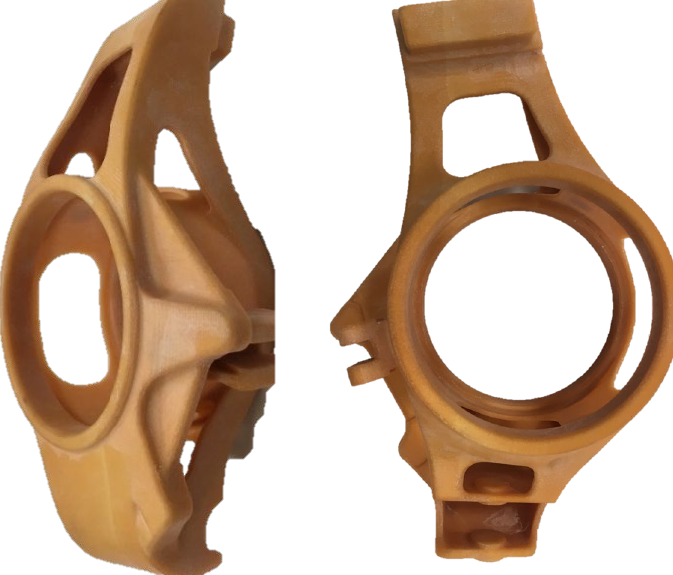
Figure 6. The upright model printed by the BJ (binder jetting) method.